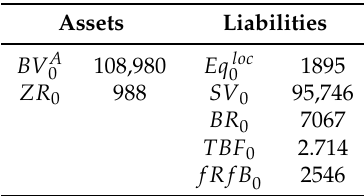
Table 3. Statutory balance sheet at time t = 0 (in A